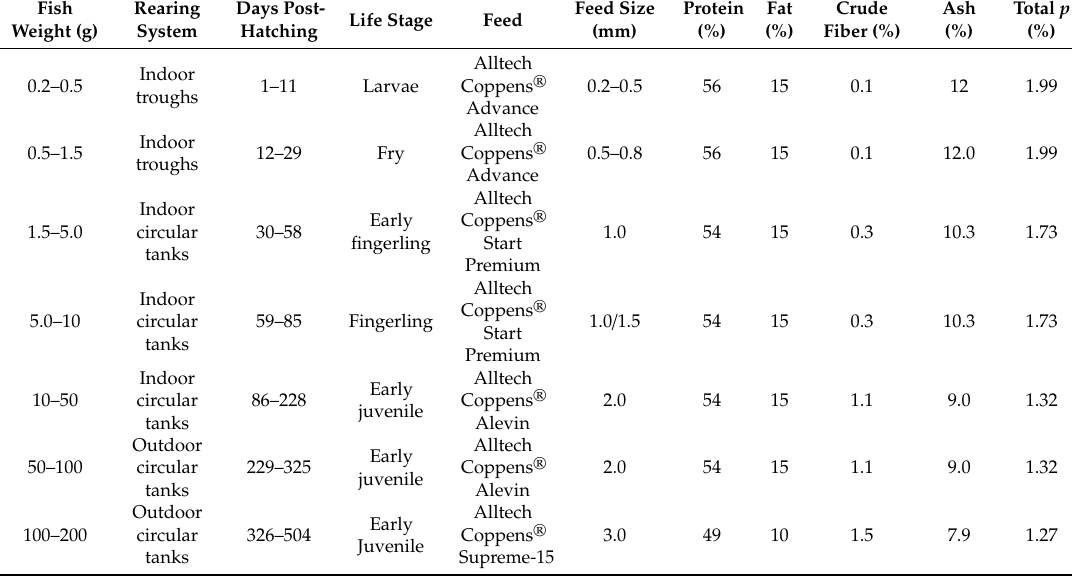
Table 1. Proximate composition and pellet size of the feed relative to the fish developmental